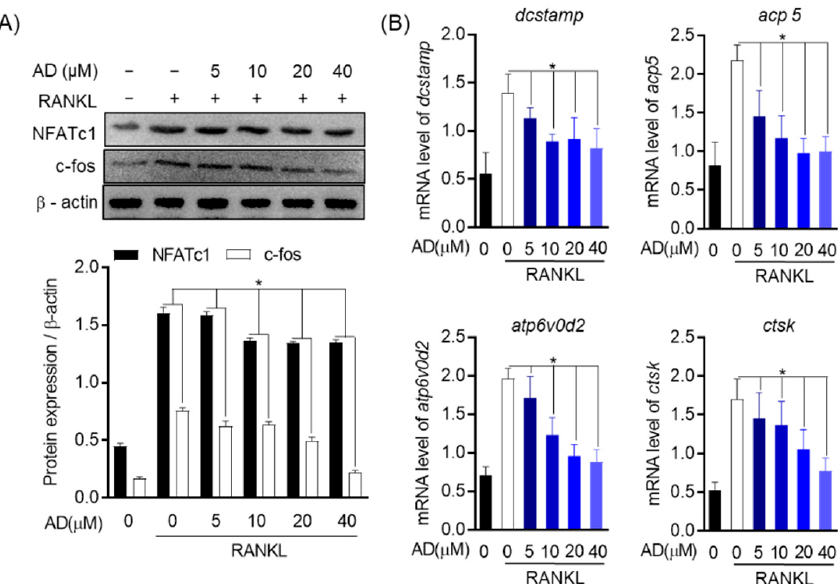
Figure 7. AD decreases the expression of osteoclast-specific genes and transcription factors. ( A ) Total proteins from RAW264.7 stimulated with or without RANKL or with indicated AD concentration for 24 h. The untreated with neither AD nor RANKL group was used as the negative control. Cell lysates were then analyzed by Western blot with the indicated antibodies. The protein expression of c-Fos and NFATc1 relative to β -actin, a housekeeping gene, was quantified by densitometry. ( B ) The mRNA level of osteoclast-specific genes, including dcstamp , acp5 , ATP6v0d2 , and ctsk , was analyzed by real-time PCR. * p < 0.05 versus the RANKL-treated group.